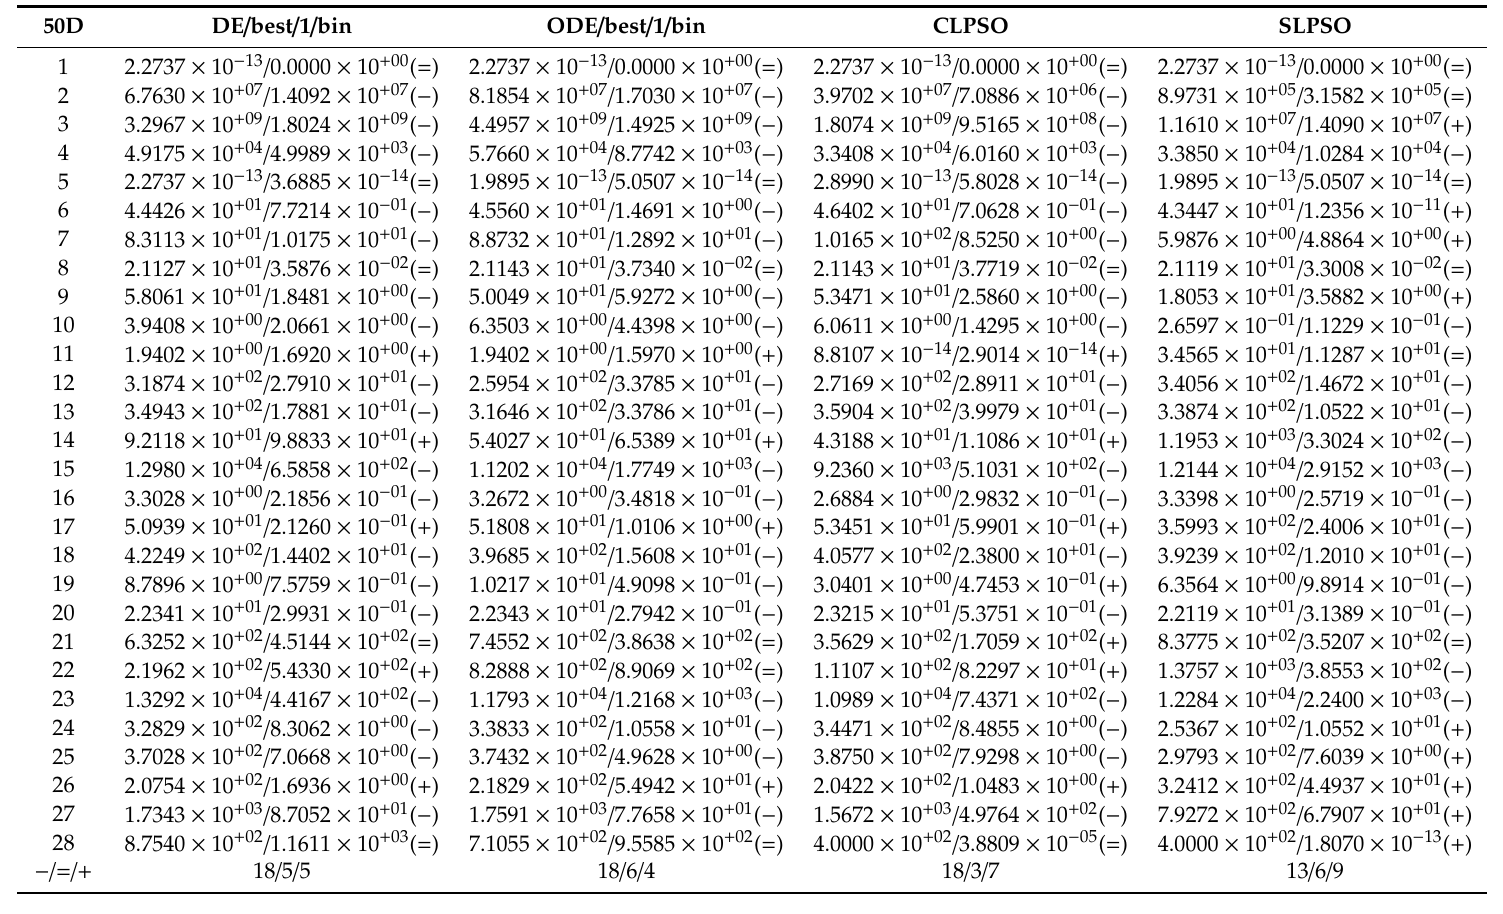
Table 4. Comparison results of mean and standard deviation of 20-run fitness error among contrasted algorithms under CEC2013 test